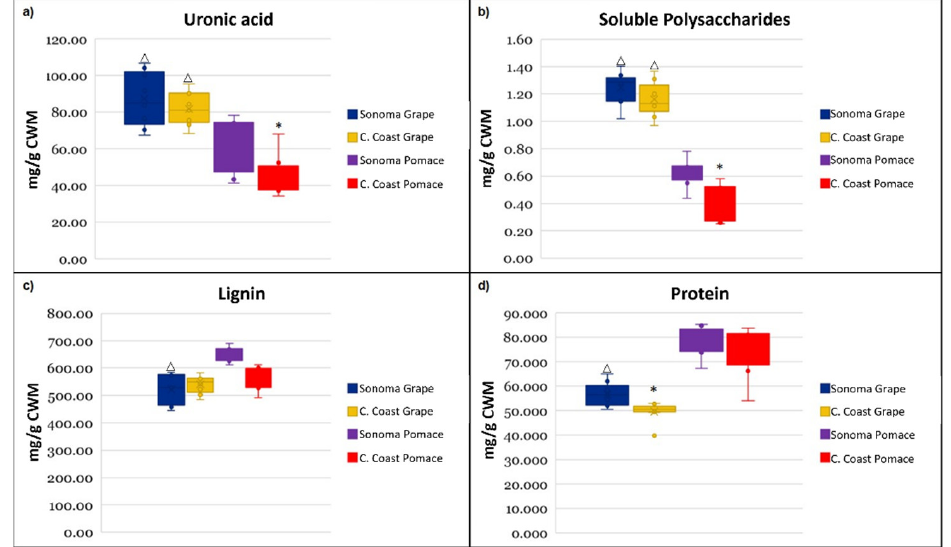
Figure 2. Box plot of ( a ) Uronic acid, ( b ) Soluble polysaccharides, ( c ) Lignin, ( d ) Protein in grape skin and pomace CWM from two different California regions ( n = 3). Significant differences between regions ( p < 0.05) are marked with a star. Significant differences between pomace and grape skin are marked with a triangle.